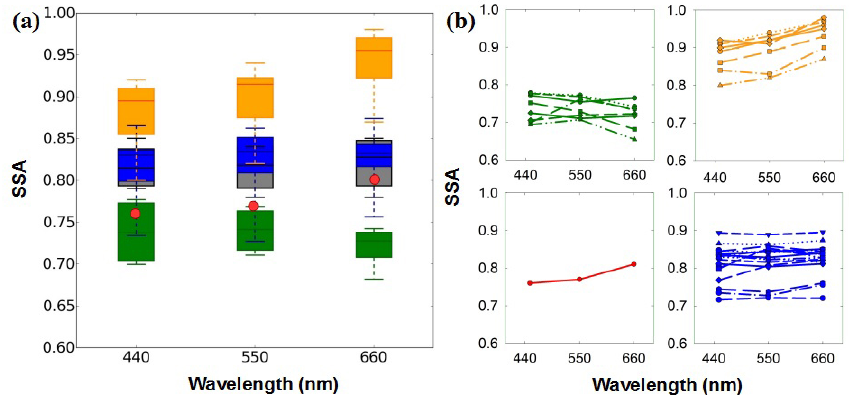
Figure 6. (a) Statistical analysis of single scattering albedo at 450, 550 and 660nm for plumes dominated by biomass burning (green), dust (orange), mixed dust–biomass burning (red), anthropogenic pollution (blue) and background particles (black). The boxes enclose the 25th and 75th percentiles, the whiskers represent the 5th and 95th percentiles and the horizontal bar represents the median. (b) Spectral SSA for the different individual plumes considered in this study. The mixed dust–biomass burning plume is represented by a dot because it is derived from measurements during only one